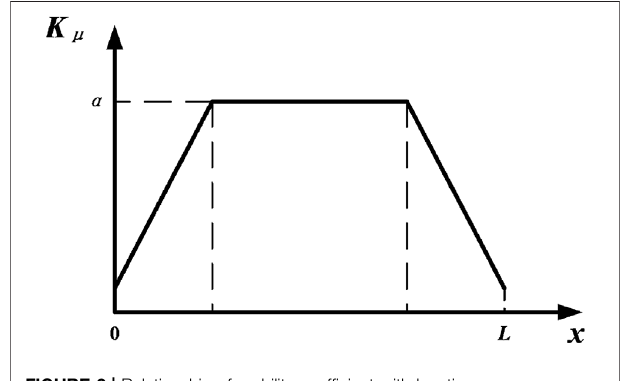
FIGURE 2 | Relationship of mobility coef fi cient with location.